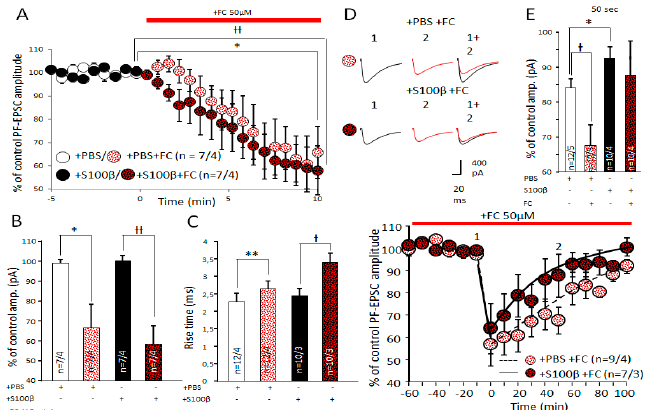
Figure 8. Downregulation of astrocytic function by fluorocitrate (FC) affects amplitude and kinetics of PF-EPSC in PF–PC synapses. ( A ) Time course of PF-EPSC amplitudes before and after